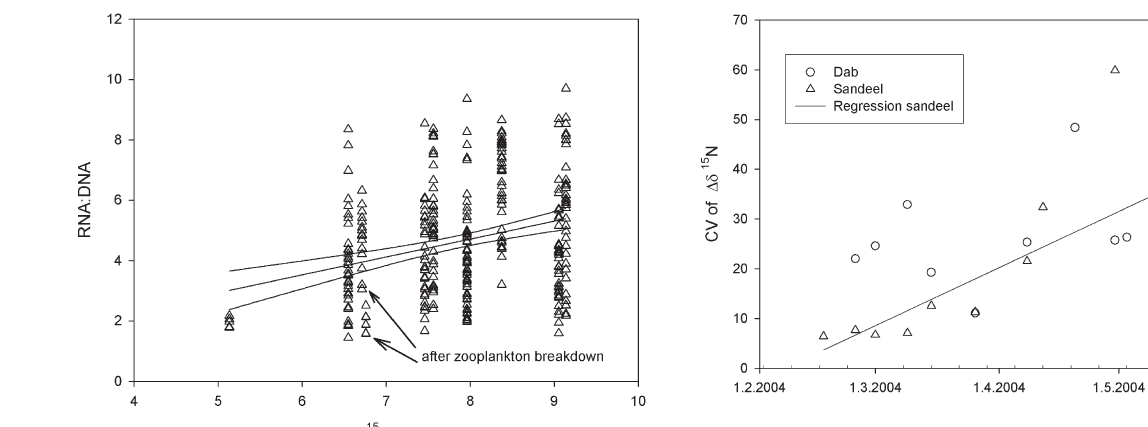
F IG . 10. – Temporal development of the coefficient of variation (CV%, calculated for each week) of the weekly mean Δδ 15 N signal F IG . 8. – Relationship between the weekly mean Δδ 15 N of the larval of larval dab and sandeel. The solid line is the regression line for sandeel and the corresponding RNA:DNA ratio. The solid line is the sandeel. linear regression line.